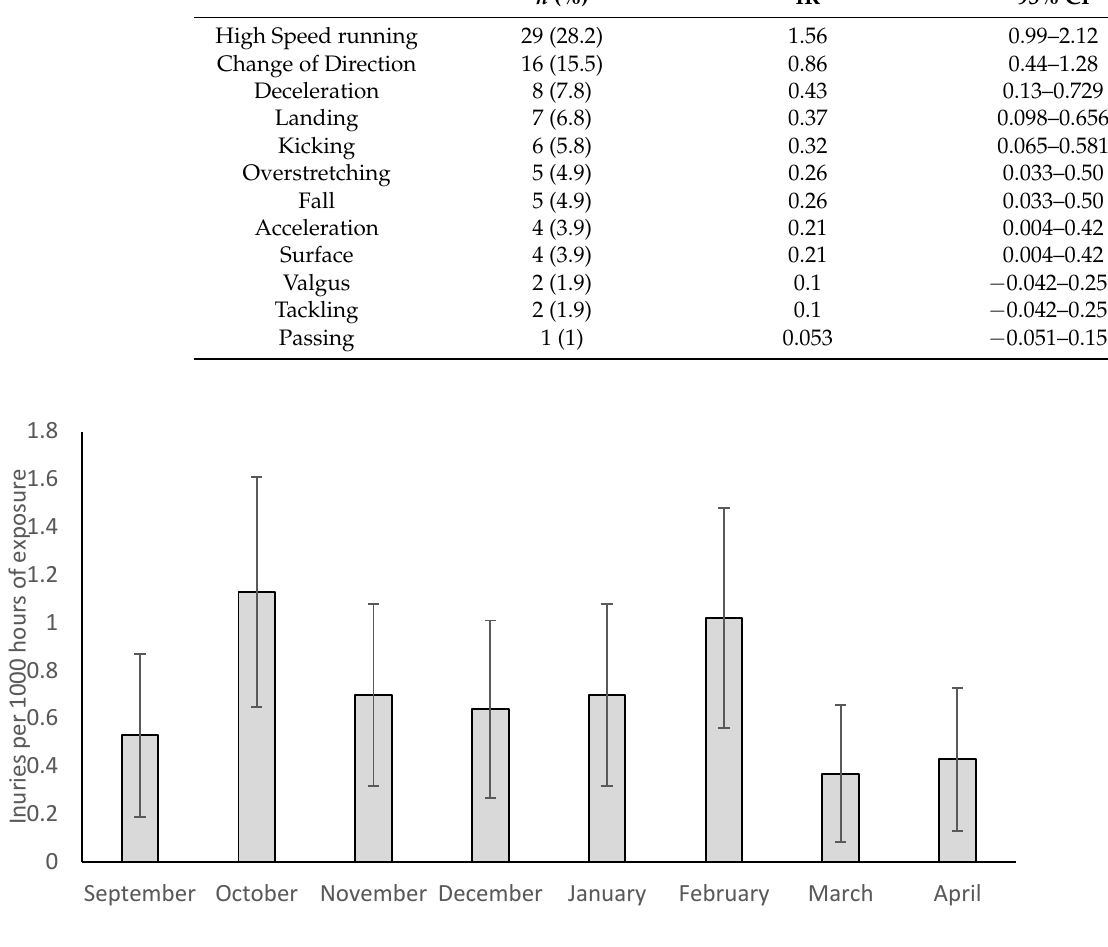
Figure 2. Annual distribution of injuries during training and games. Error bars indicate 95% confidence intervals.